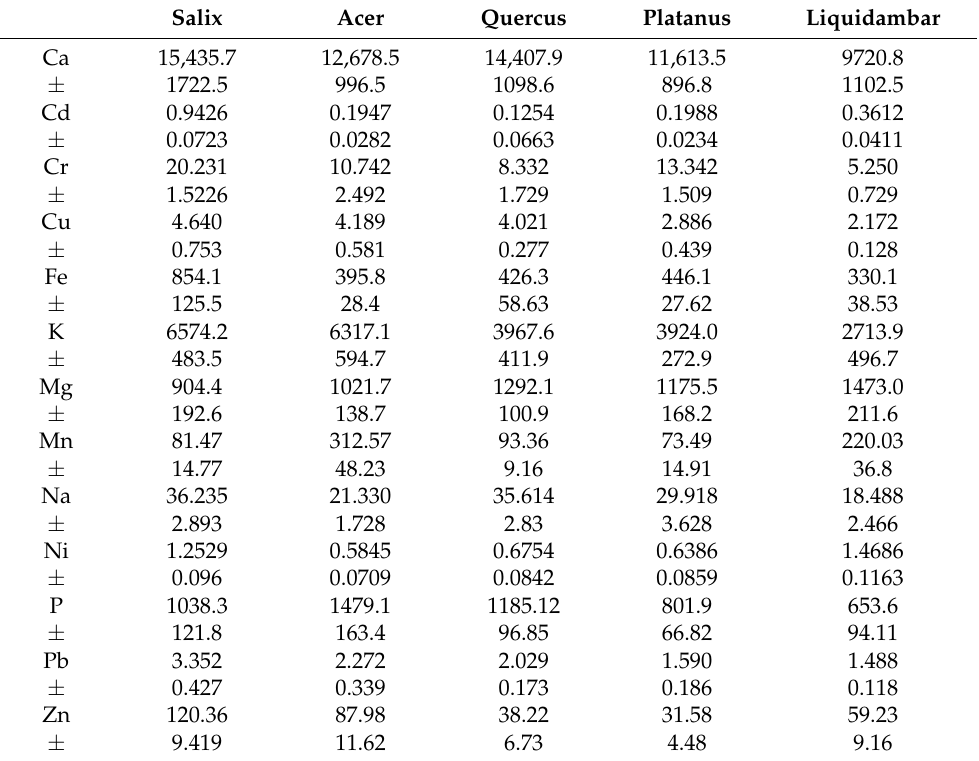
Table 2. Average values and standard deviations ( ± ) of the determined elements in the analysed materials (mg · kg − 1